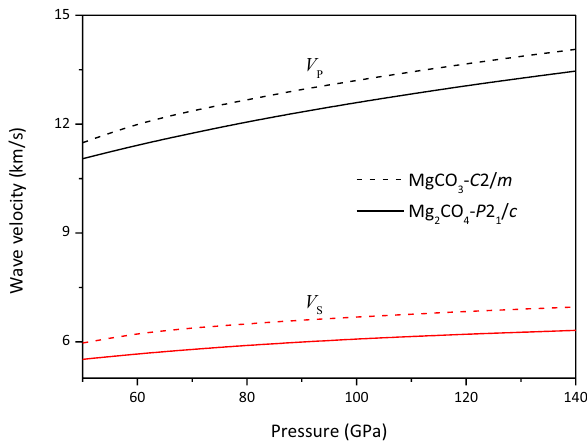
Figure 8. Compression ( V P ) and shear ( V S ) velocities of MgCO 3 - C 2 /m and Mg 2 CO 4 - P 2 1 /c .